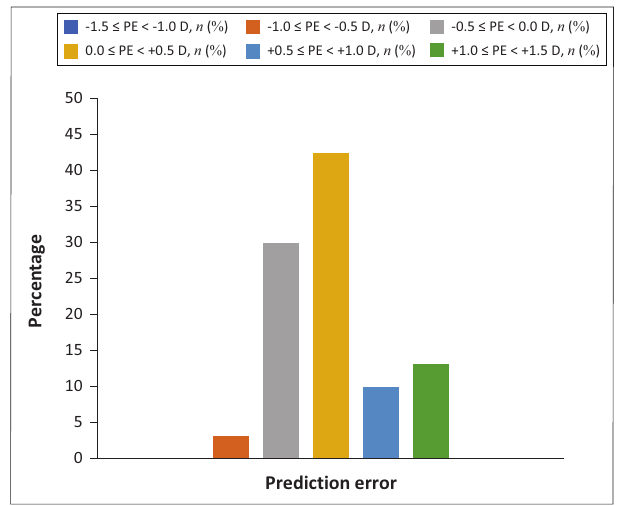
AL, axial length. FIGURE 3: Target versus actual postoperative SE in group 1.